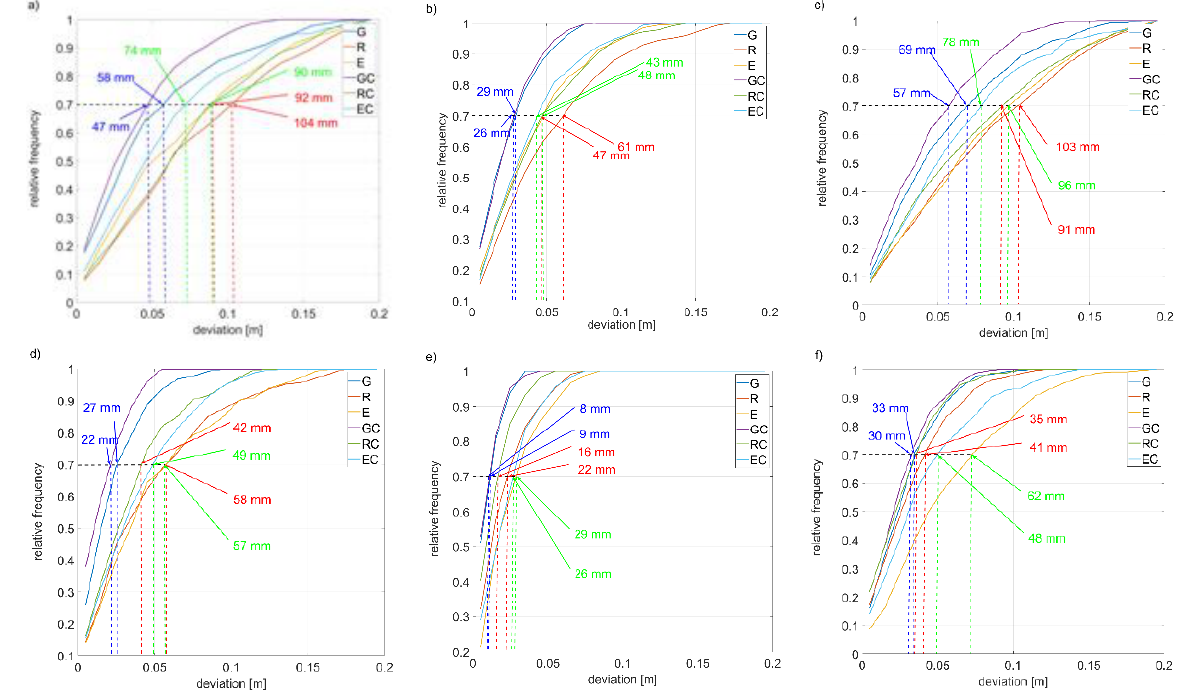
Figure 11 . Cumulative histograms for 0.5- a ) North, b ) East, c ) Up, and 1.0-hour, d ) North, e ) East, Figure 11. Cumulative histograms for 0.5- ( a ) North, ( b ) East, ( c ) Up, and 1.0-h, ( d ) North, ( e ) East, f ) Up, session for autonomous solution. ( f ) Up, session for autonomous